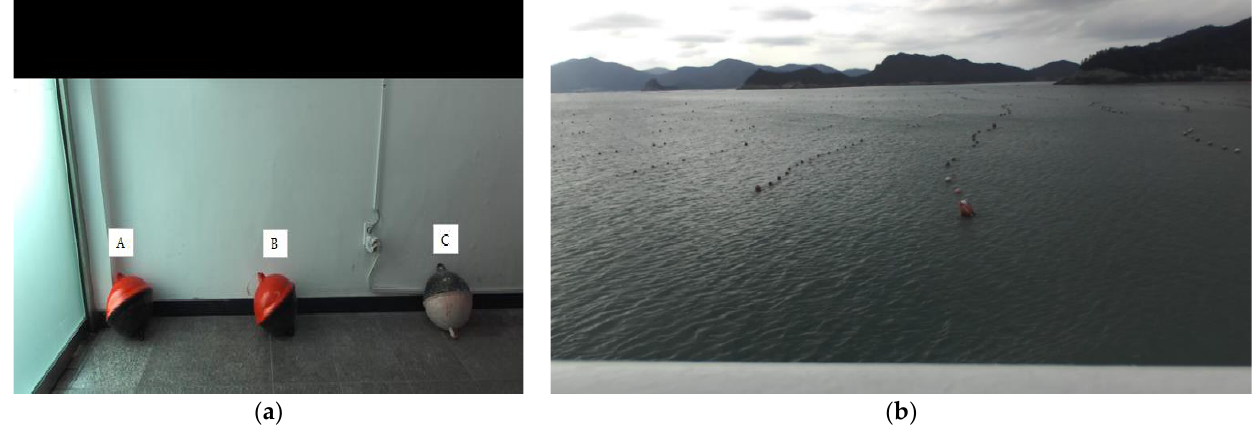
Figure 11. Aquaculture buoy: ( a ) Experiment A and ( b ) Experiment B.